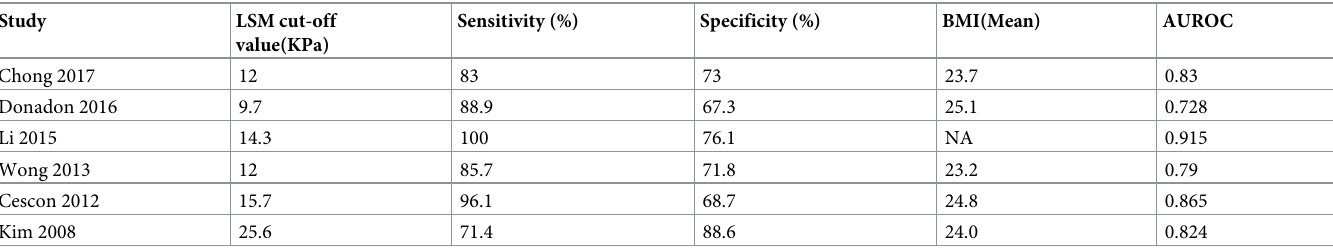
Table 2. Diagnostic data of each studies evaluating the performance of TE for postoperative complications. Study